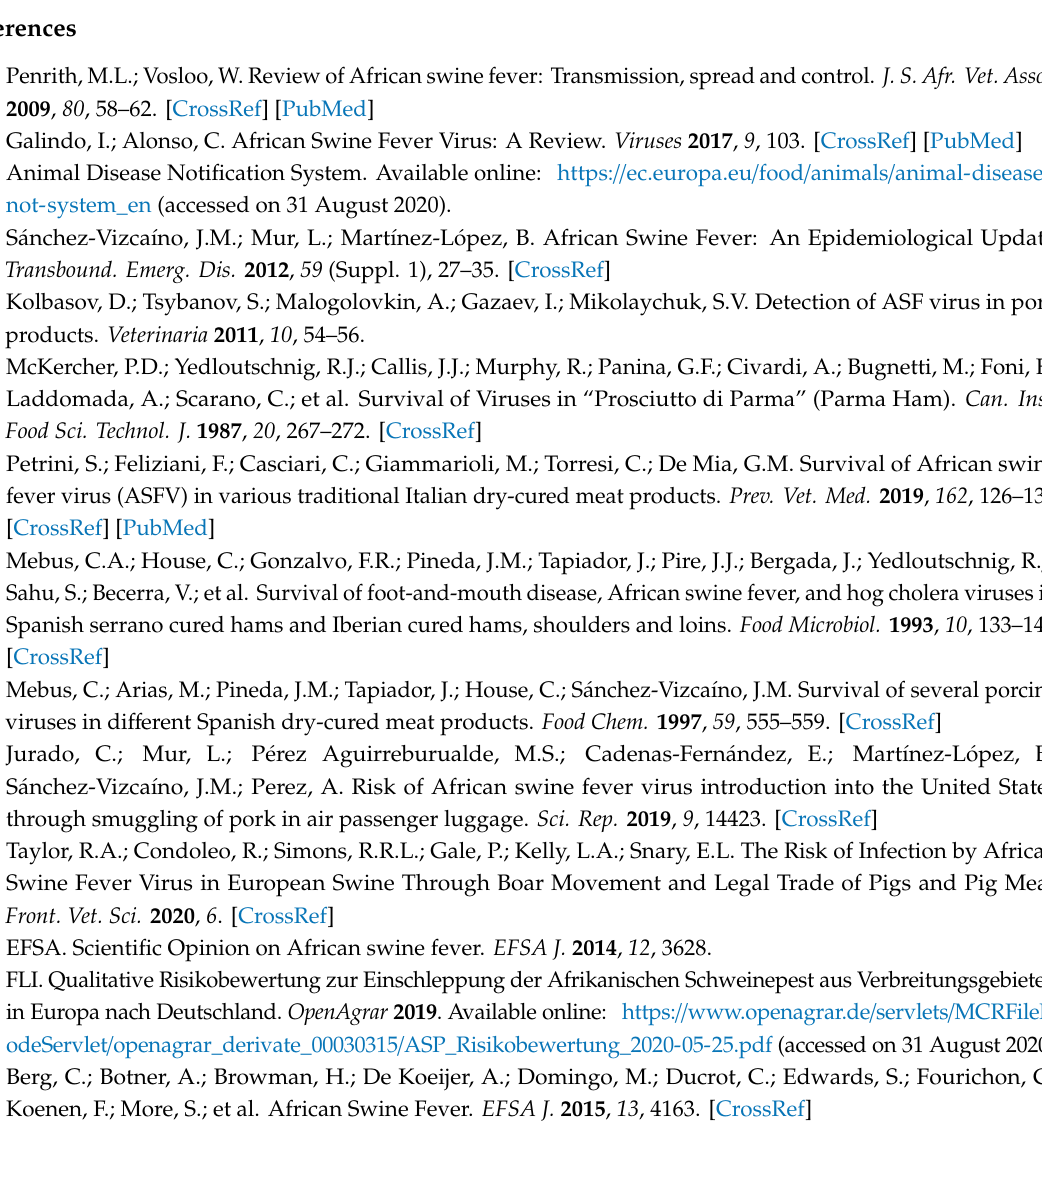
Figure S1: ASFV genome copy numbers as determined by qPCR in blood, spleen and bone marrow, Figure S2: ASFV genome copy numbers as determined by qPCR in muscle, skin and faeces, Figure S3: Storage of carcass material under di ff erent conditions, Table S1: Summary of raw data from qPCR (as Cq-values) and HAT of all investigated samples during storage under various conditions over